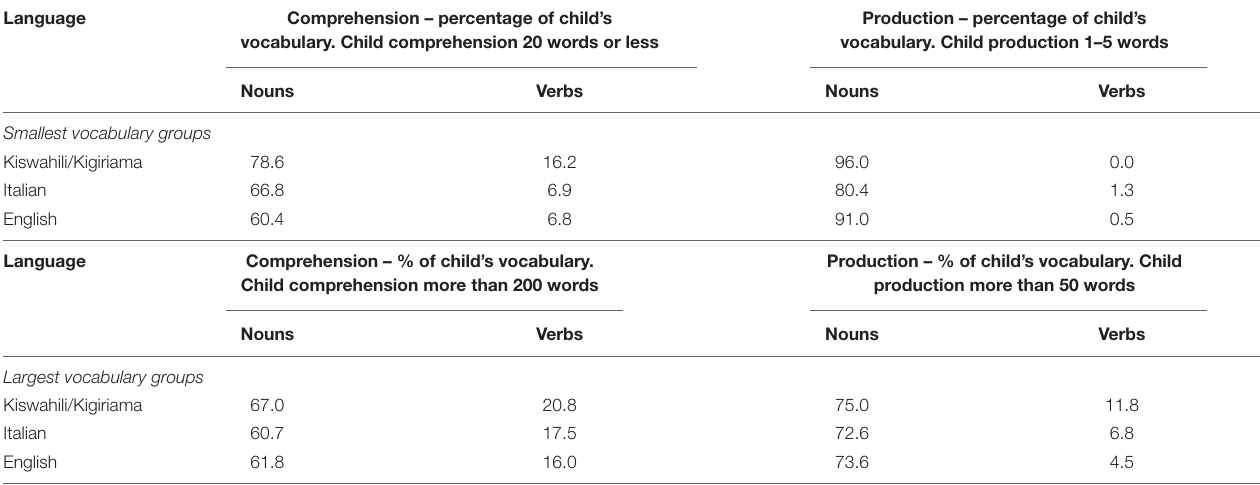
TABLE 9 | Cross-linguistic comparisons of noun and verb use by children in the smallest and largest vocabulary groups.